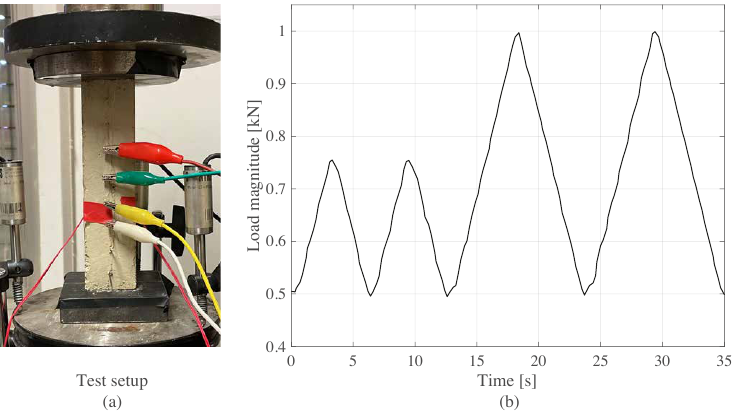
Figure 4. Electromechanical tests: ( a ) experimental setup of a smart earth composite sample, and ( b ) applied load–time history.